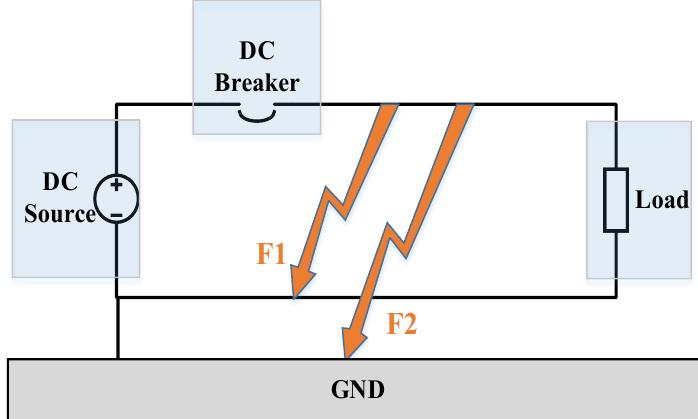
Figure 4. Flow diagram of simulation process.